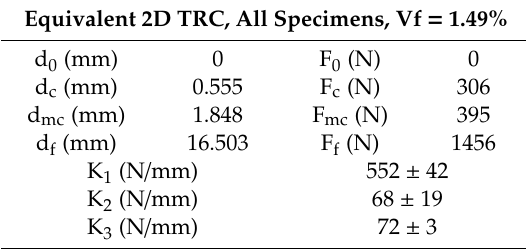
Figure 14. Flexural comparison of averaged curves of all layups. Table 7. Averaged flexural experimental parameters for the equivalent 2D TRC layup.